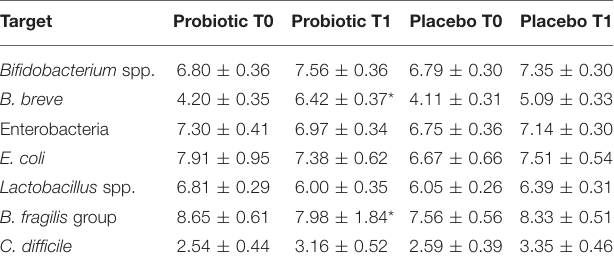
TABLE 7 | Mean counts (Log CFU/g of faces) of different microbial groups analyzed in stool samples of bottle-fed